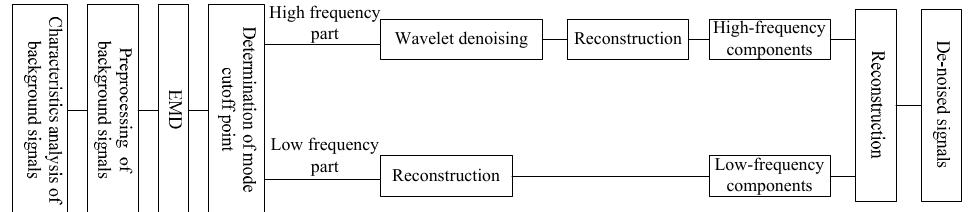
Figure 4. The denoising process of signals.